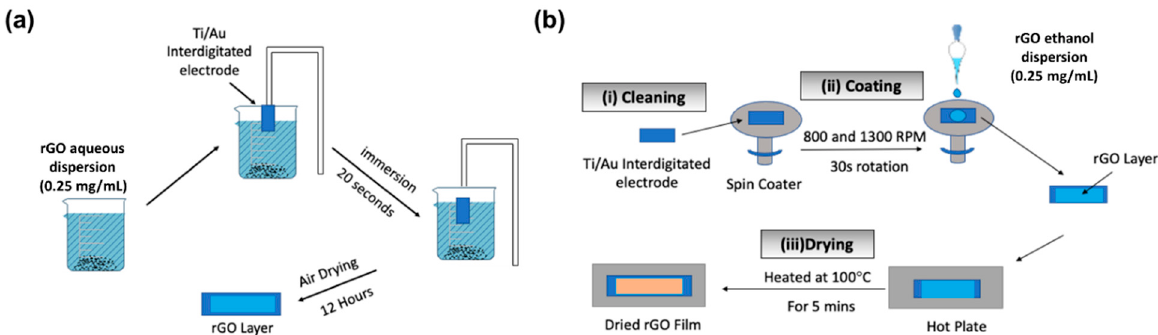
Figure 1. Schematic illustration of ( a ) the dip coating, and ( b ) the spin coating method for sensing layer